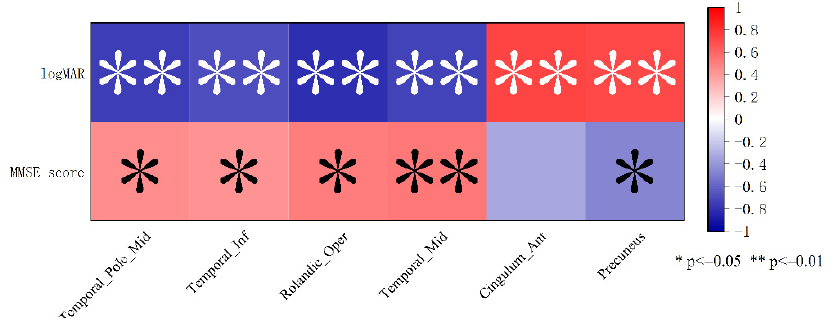
Figure 6. Correlation analysis results. Notes: Red indicates positive correlations; blue indicates negative correlations.